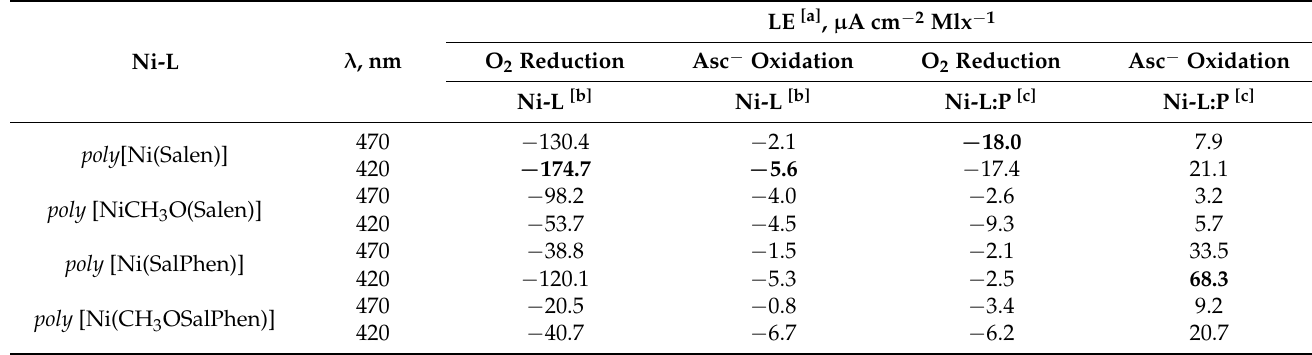
Table 1. Relative light efficiencies of the films.